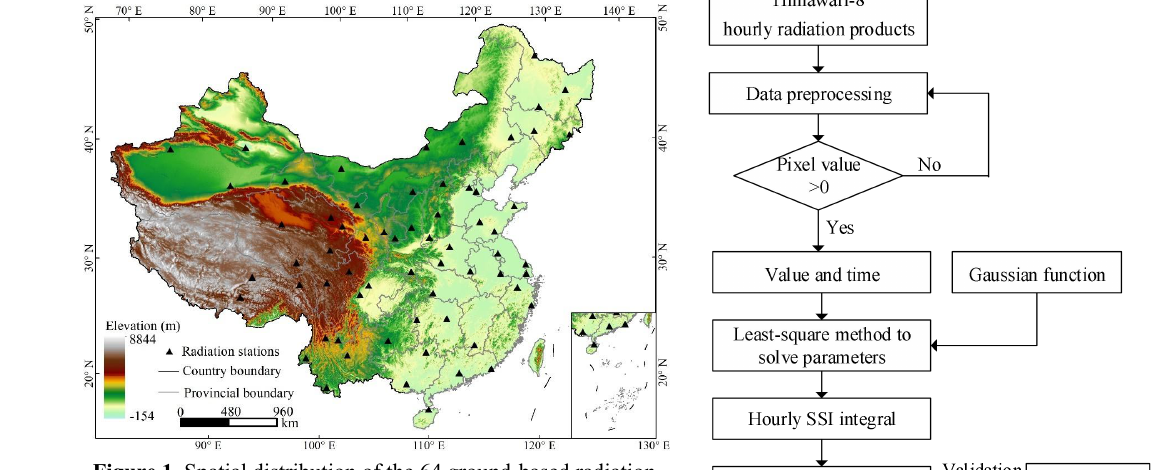
Figure 1 . Spatial distribution of the 64 ground-based radiation stations over China.